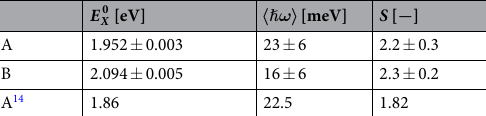
−   0 denotes the zero temperature exciton energy,  ω 〈 〉 represents the average phonon energy contributing where E X to the temperature change of the exciton energy, and S is the effective electron-phonon coupling constant. Best-fit 0 , ω 〈 〉  , and S for the A and B excitons are shown in Table 1 along with results from measurements values for E X done before the trion was discovered 14 . There is good agreement with the previous measurements with the excep- tion of the zero temperature energy. Given that the trion was not known at the time of the earlier work, we suspect that the low-temperature spectra were fit to the trion peak instead of the A exciton peak, which would account for the significant difference in zero temperature energy. Recalling that the A and B excitons are split by spin-orbit coupling, and noting that ω 〈 〉  and S are different for the A and B exciton, we conclude that the spin-orbit splitting of the valence band slightly decreases as temperature increases. Trion Tail Length and Zero-Momentum Trion Energy. Figure 4 contains three panels to highlight the changes to the trion PL spectrum with temperature. Panel a shows the trion fit component of the spectra at each temperature, and data with contributions due to background and excitons subtracted. Dashed lines, as guides for the eye, are drawn to show how peak shift and tail length evolve with temperature, and panels b and c further focus on each of these important features. Qualitatively, we see the expected temperature dependent effects to the trion spectra. As predicted by our theory developed above, the low-energy tail gets longer and the peak red-shifts relative to the zero-momentum trion energy as the temperature increases. Note that this red-shift is in addition to the red-shift caused by band gap renormalization discussed in the previous section.